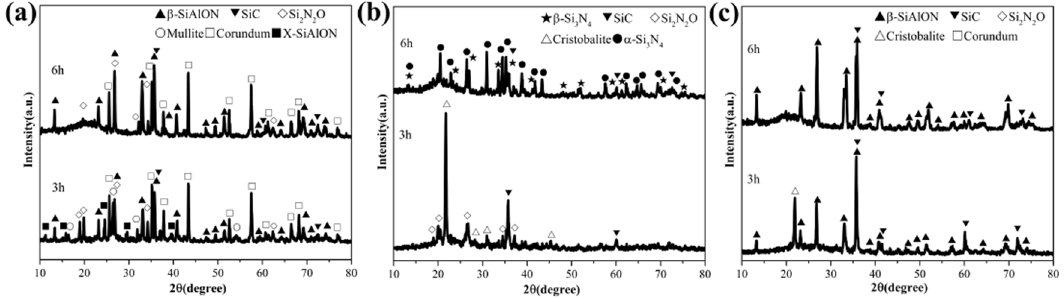
Figure 4. XRD patterns of the products obtained from different starting materials with different holding times at 1400 °C ( a ) pulverized coal furnace fly ash ( b ) diatomite ( c ) raw illite.